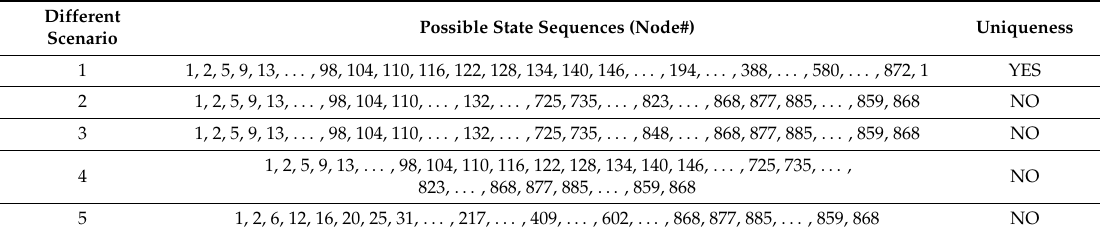
Table 4. Possible state sequences of TSP control